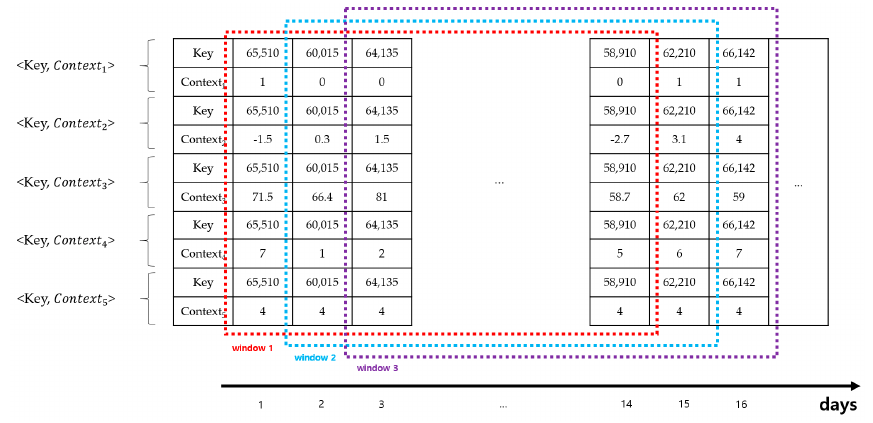
Figure 4. <Key, Context [1, c ] > pairs and sliding windows.